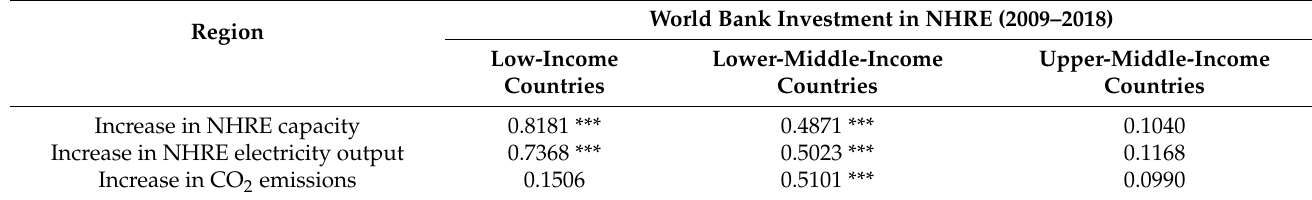
Table 6. Correlation coefficients between indicators.